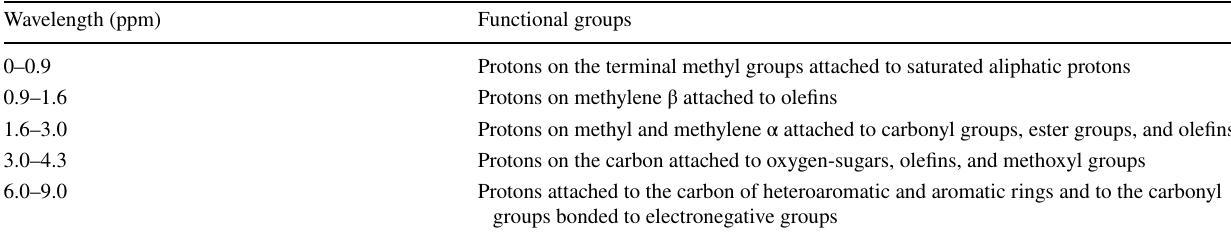
Table 5 H 1 -NMR peak assignments of humic substances